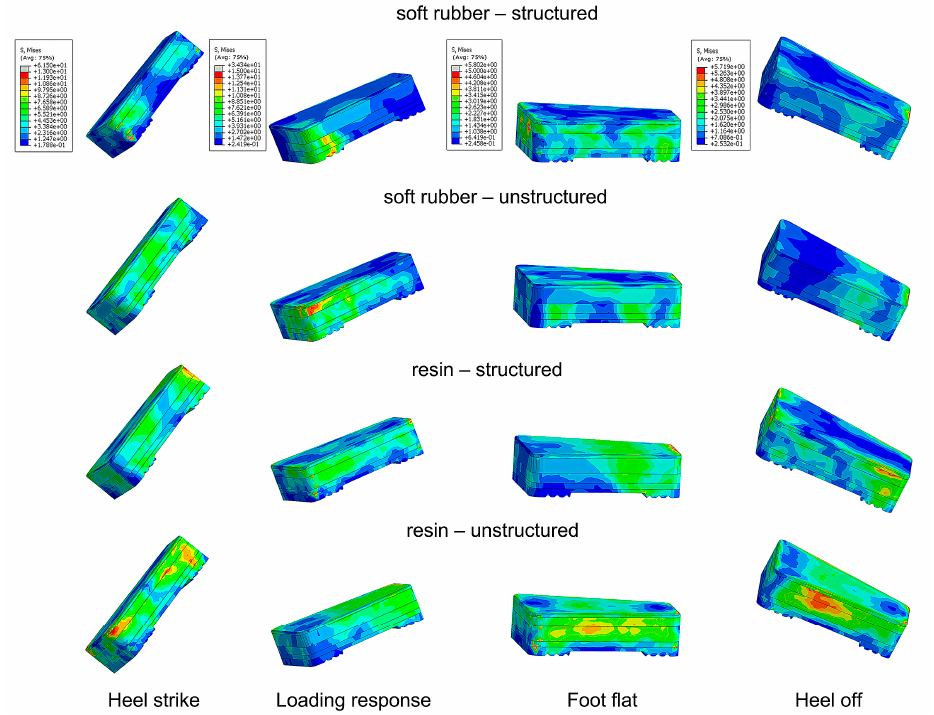
Figure 6. Distributions of the maximum principal stress of the bionic heel pads at four key time instants during normal walking gait in FE simulations.